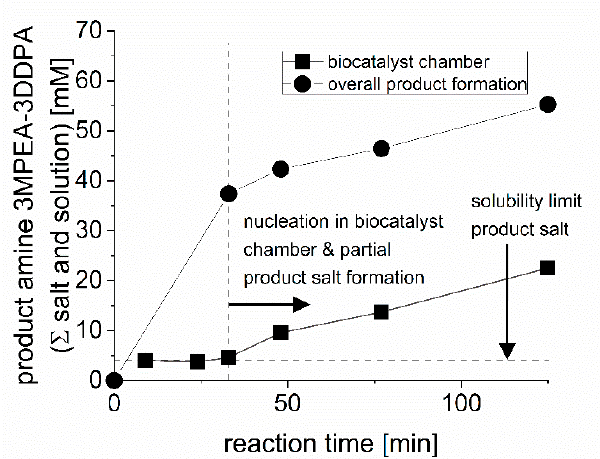
Figure 6. Product formation in the combined triple vessel concept; 30 °C, 25 mM HEPES buffer pH 7.5, 100 mM 3MAP, 60 mM IPA-3DPPA, 100 mM additional isopropylamine and 5 mM PLP (within entire solution).